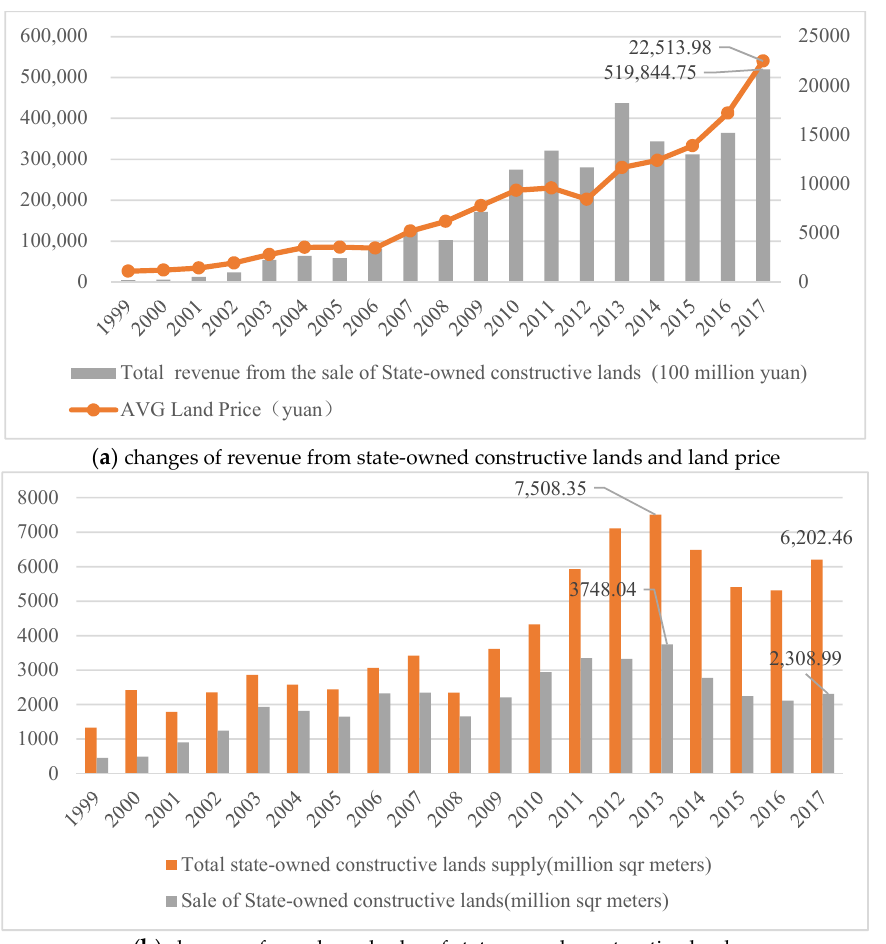
Figure 10. The total revenue and supply from selling or transferring state-owned construction lands from 1999 to 2018. Source: China Land and Resources Yearbook: 2000–2018.